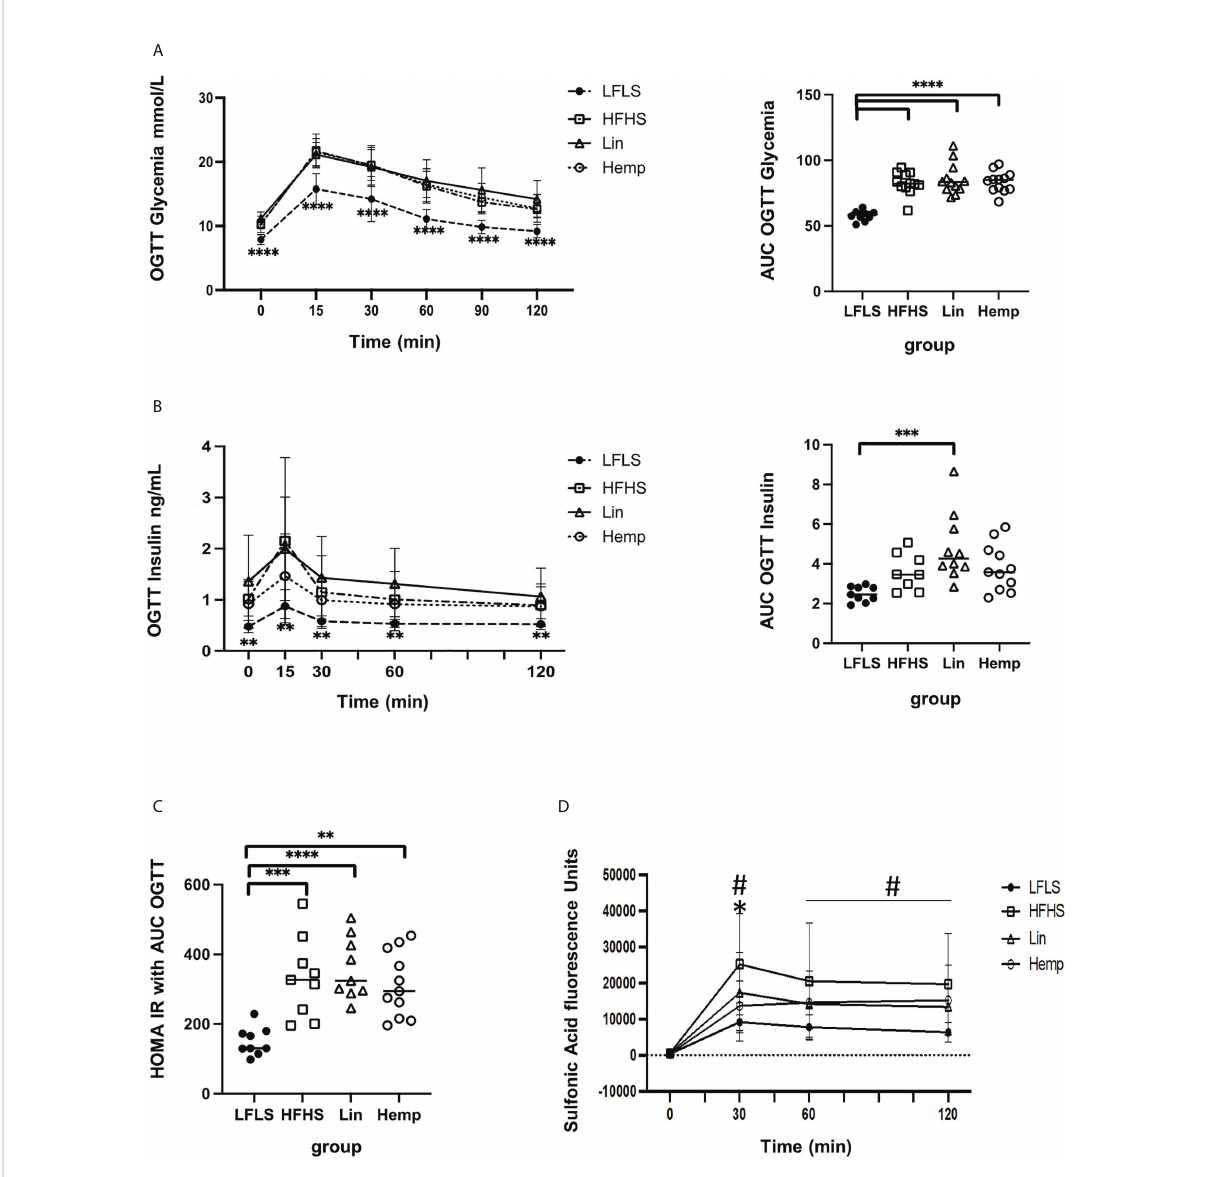
FIGURE 2 Glucose and insulin homeostasis after 8 weeks of HFHS diets. (A) Glycemic excursion curves during OGTT (left, signi fi cant difference between LFLS vs. all the groups fed with HFHS diets) with the corresponding area under the curve analysis of glucose (right); (B) Insulinemic excursion curves during OGTT (left, signi fi cant difference between LFLS vs. all the groups fed with HFHS diets) and the corresponding area under the curve analysis; (C) HOMA-IR calculated using glucose and insulin AUCs (area under the curve) from OGTTs. * p < 0.05); ** p < 0.01; *** p < 0.001); **** p < 0.00001). (D) Intestinal permeability as measure by sulfonic acid levels in blood after administration with the OGTT: # signi fi cant difference between LFLS versus HFHS group ( p < 0.05). *signi fi cant difference between Hemp versus HFHS group ( p <